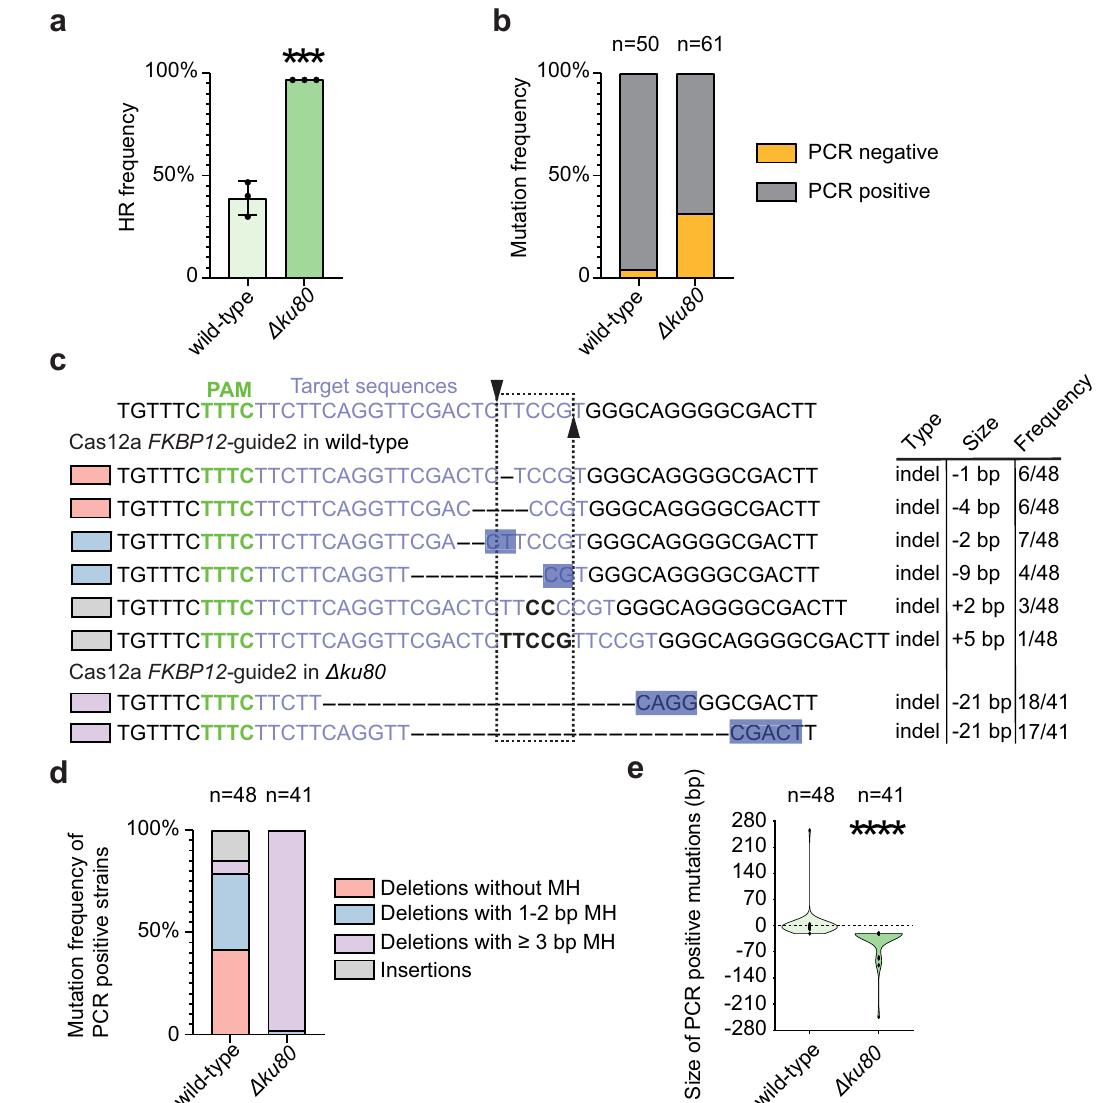
Fig. 8 | The involvement of Ku80-independent DSB repair in large and microhomology-mediated DNA deletions. a HR frequency in wild-type and Δ ku80 . A total of 90 transformants were collected from n =3 biological replicates. TheHRfrequencywasdetermined perreplicate,shownasablackdot.***indicates a p -value ≤ 0.001usingunpaired t -test,two-sided, p -value=0.0003.Theplotshows ameanvalue0.39+/ − 0.08389forwild-typeandmeanvalue0.97+/ − 0for Δ ku80 . b MutationfrequencyofPCRnegativeandPCRpositiveoutcomesinCas12a-edited FK506 R transformants in the background of wild-type or Δ ku80 . The number of independent transformants genotyped (x) is listed ( n =x) collected from two independent transformations for wild-type and three for Δ ku80 . The frequencies show the average outcome across replicates. c Sanger sequencing for representa- tive mutation outcomes from Cas12a FKBP12 -guide2 in wild-type and Δ ku80 . PAM and target sequences are highlighted with different colors as indicated. Black